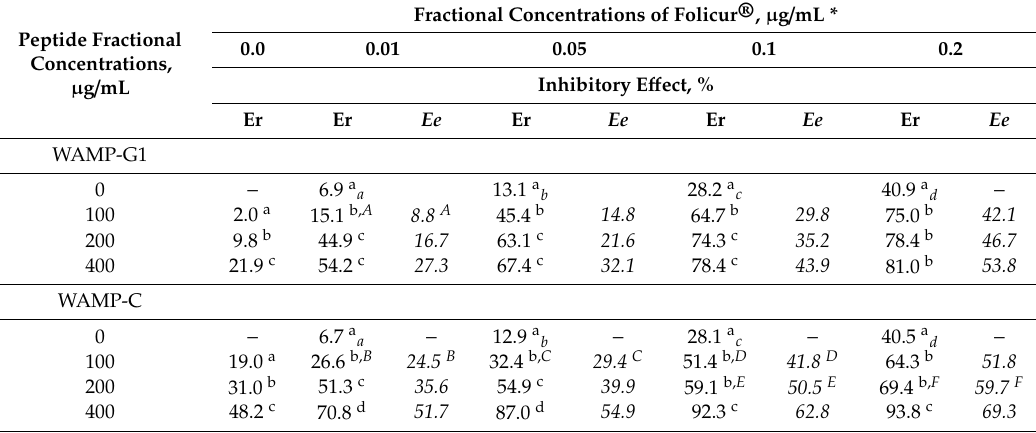
Table 3. Observed inhibitory e ff ect (Er) on conidial germination of A. solani by Folicur ® EC 250 combined with the synthesized peptides, compared to the calculated inhibitory e ff ect (Ee), when combinations had only an additive